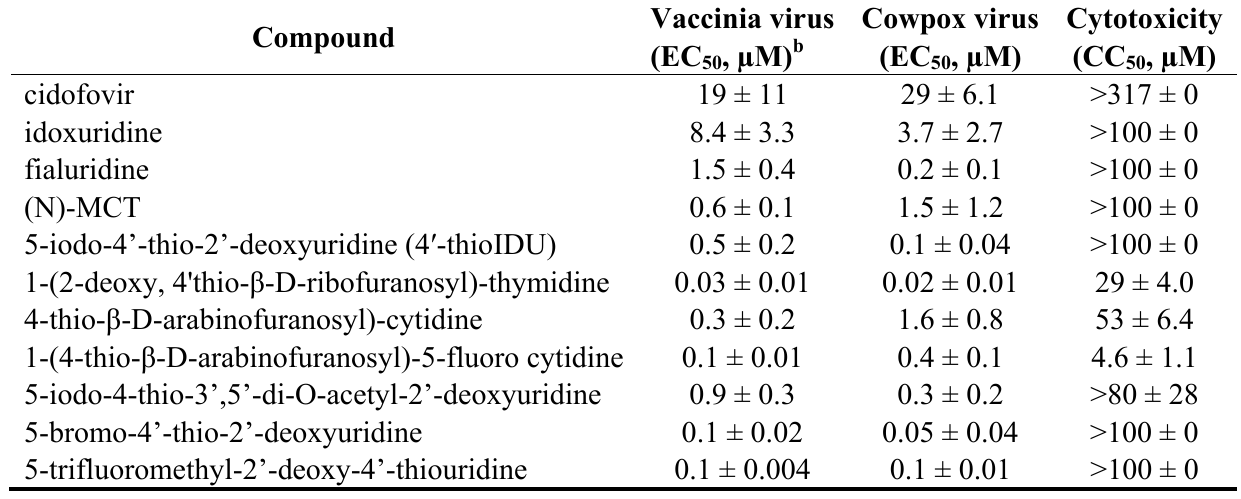
Table 1. Activity of thymidine analogs against vaccinia virus and cowpox virus a